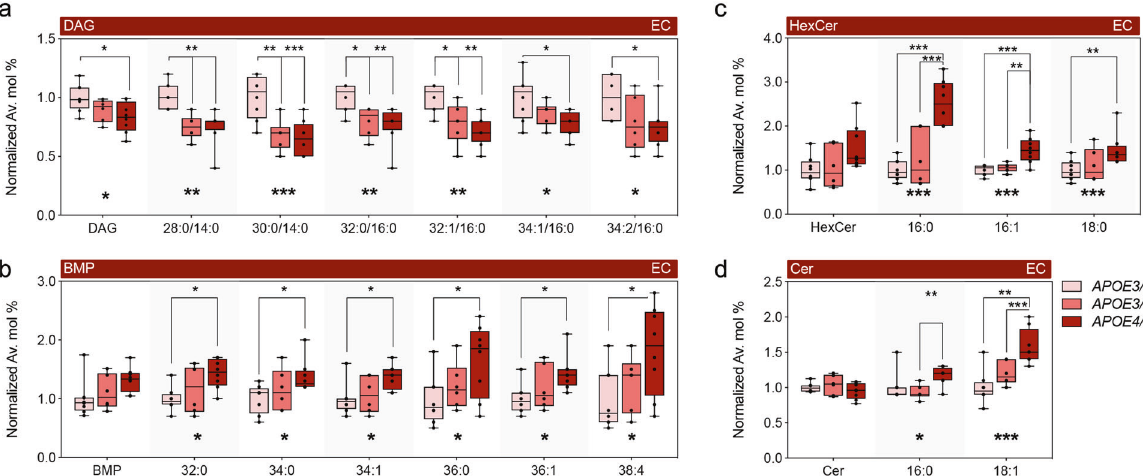
Fig. 2 Dominant and semi-dominant effects of APOE 4 expression on lipid composition in the EC in aged APOE mice. a – c Normalized average mol% (fold-change) of ( a ) DAG, ( b ) BMP, ( c ) Hex and ( d ) Cer lipid species from the EC of aged APOE targeted replacement mice. Lipids were annotated per total acyl carbons and degree of unsaturation. Data represent median ± max/min. One-way ANOVA followed by Tukey ’ s post-hoc test for multiple comparisons was performed; n = 8, 6, and 8 for EC and n = 7, 8, and 7 for PVC in APOE3/3 , APOE3/4 , and APOE4/4 mice, respectively. Kruskal – Wallis H test con fi rmed statistically signi fi cant difference in levels of BPM 32:0 ( p = 0.03), HexCer 16:0 ( p = 0.003) and Hex Cer 16:1 ( p = 0.003). * p < 0.05, ** p < 0.01, and *** p <